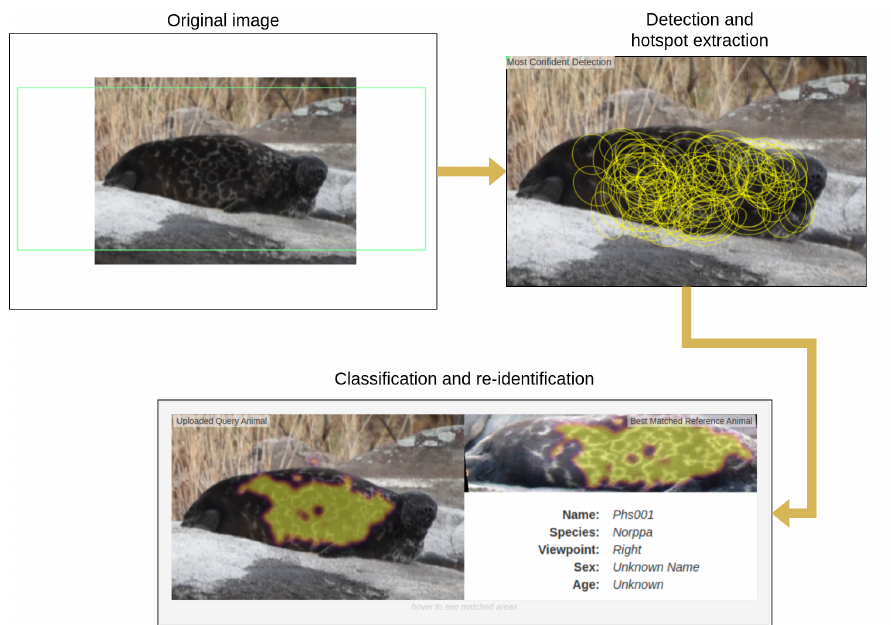
Figure 6. The HotSpotter method applied to an image of a Saimaa ringed seal. Yellow circles represent the extracted features or “hot spots”. The matching areas between two images, are highlighted with yellow. The matching image is chosen according to the score.